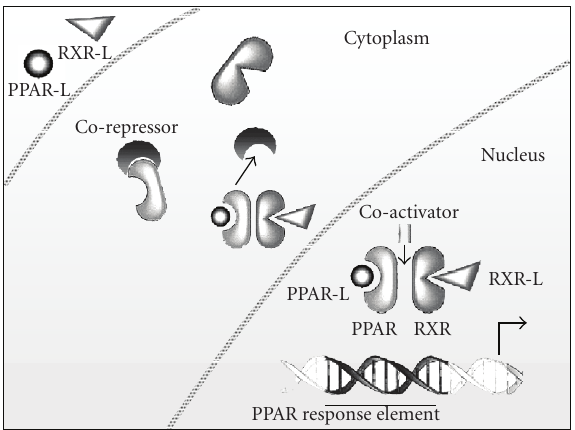
Figure 1: Mechanism of PPAR action. PPARs in response to ligand binding in the cytosol, dimerize with RXR, recruit coactivators and release corepressor; in the nucleus a multimolecule complex, formed by PPAR, PPAR ligand, RXR, RXR-ligand, and accessory proteins bind PPRE DNA sequences in the promoters of target